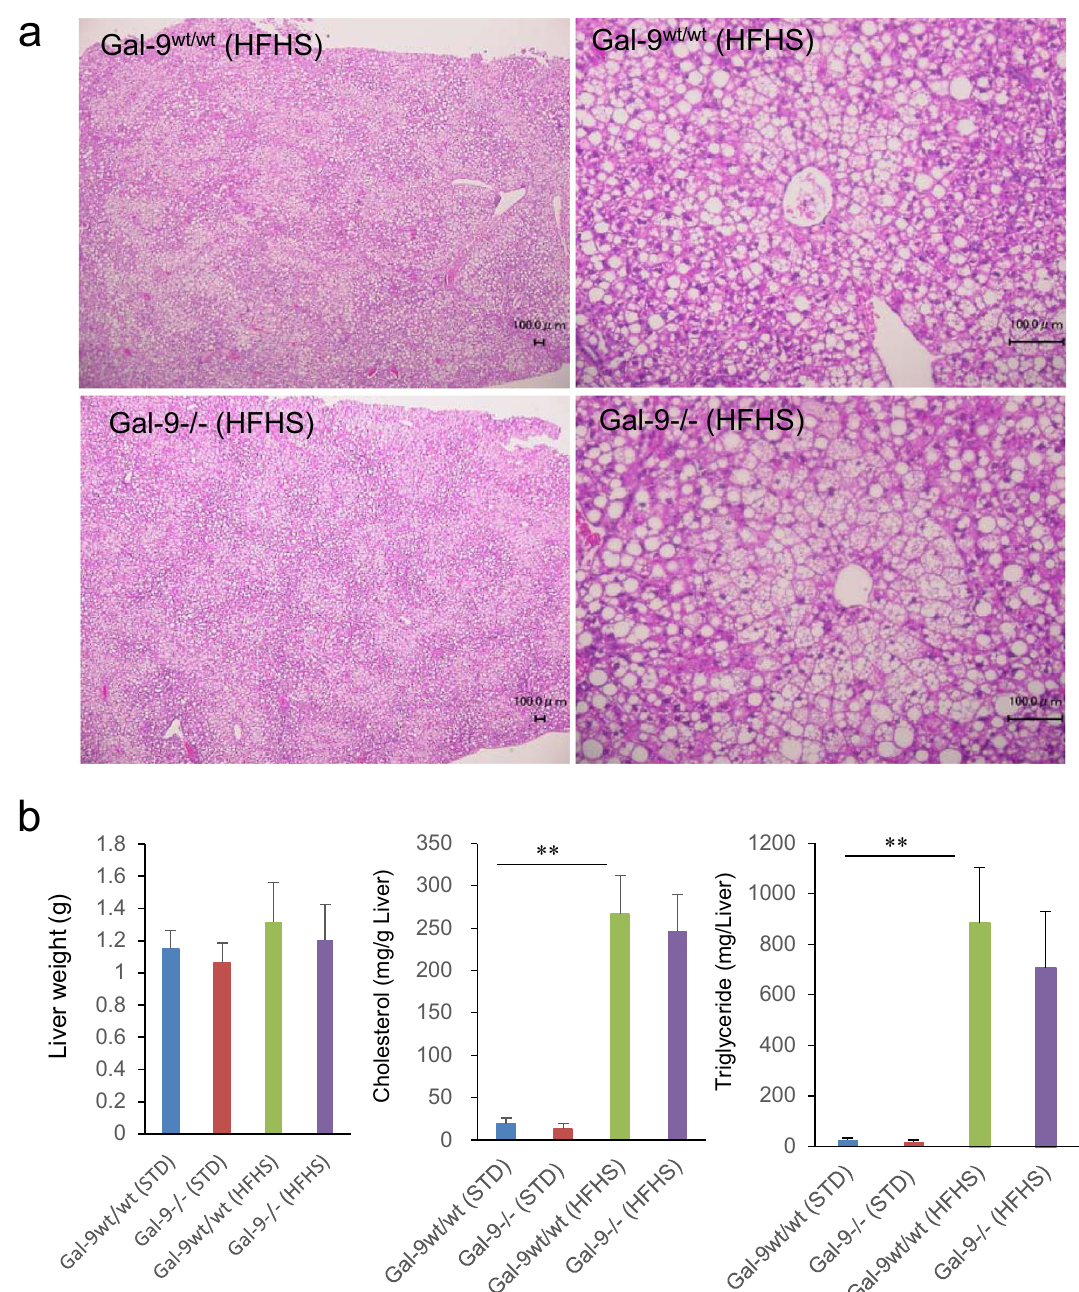
Figure 2. Histology of the liver, weight, cholesterol, and triglyceride contents. ( a ) PAS staining of the liver. There are no differences in lipid droplets in the liver. ( b ) Liver weight, cholesterol and triglyceride contents. Gal-9 wt/wt (STD), n = 8; Gal-9 −/− (STD), n = 5, Gal-9 wt/wt (HFHS), n = 7; Gal-9 −/− (HFHS), n = 5 in liver weight. Gal-9 wt/wt (STD), n = 5; Gal-9 −/− (STD), n = 6, Gal-9 wt/wt (HFHS), n = 5; Gal-9 −/− (HFHS), n = 6 in cholesterol and triglyceride contents. *, p < 0.05; **, p < 0.01. One-way ANOVA with